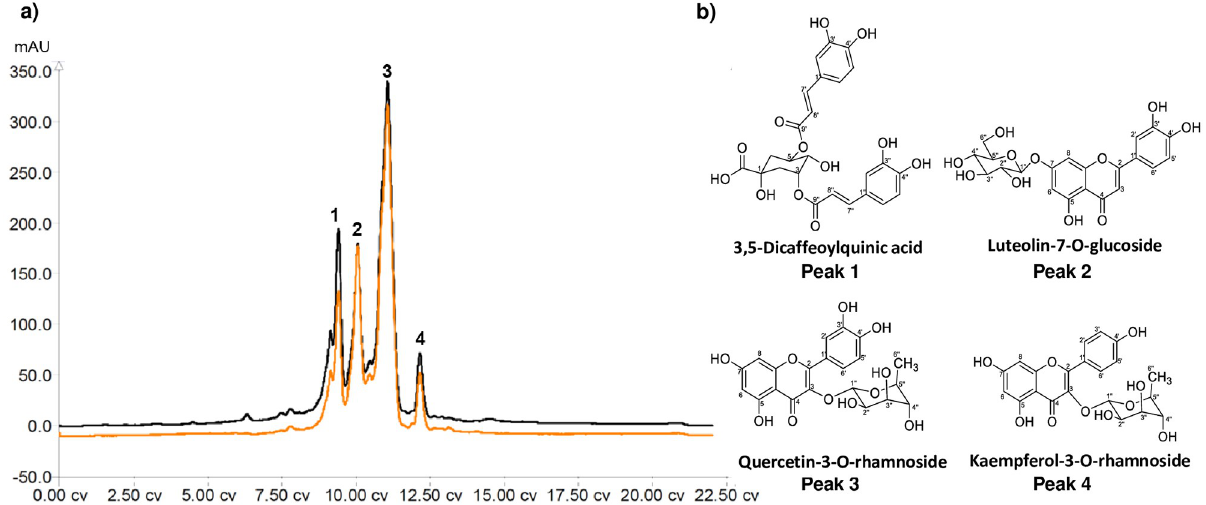
Fig 3. Isolation of major compounds from F3: EtOH/EtOAc. a) Chromatogram of subfraction F3 from MPLC separation on a reversed phase silica gel column eluted with gradient system of MeOH and H 2 O (3–97%). The chromatographic signals at 256 nm (black) and 366 nm (orange) were detected. b) Chemical structures of the known compounds corresponding to peak1-4 (see S1 and S2 Appendices for the HRMS and NMR spectra,